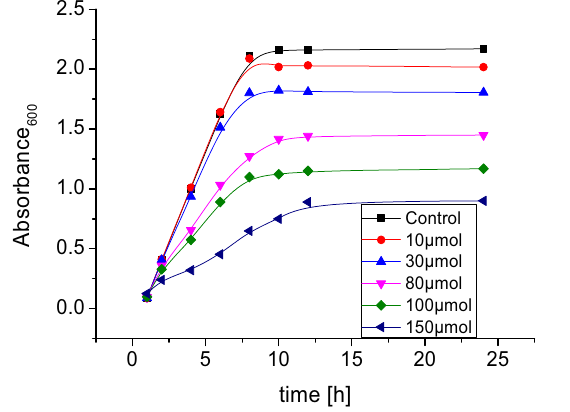
Figure 3: Growth curves of E. coli during the course of a 24 h culti - vation in the presence of 10; 30; 80; 100; and 150 μ mol of the complex 1 .